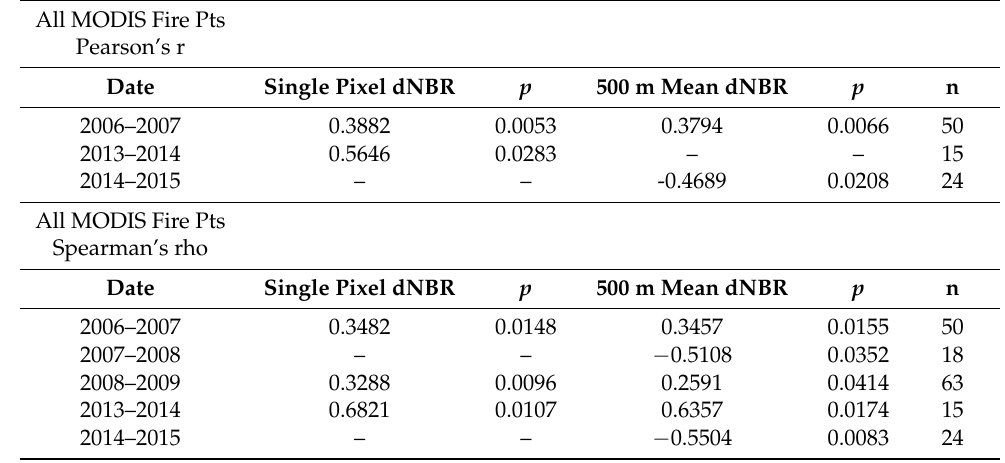
Figure 6. Fire radiative power from MODIS active fire detection compared with mean Landsat (ETM+ or OLI) dNBR for 500 m radius around each 1 km MODIS fire points, 2004–2005 to 2014–2015. Table 4. Correlations between dNBR and MODIS fire radiative power